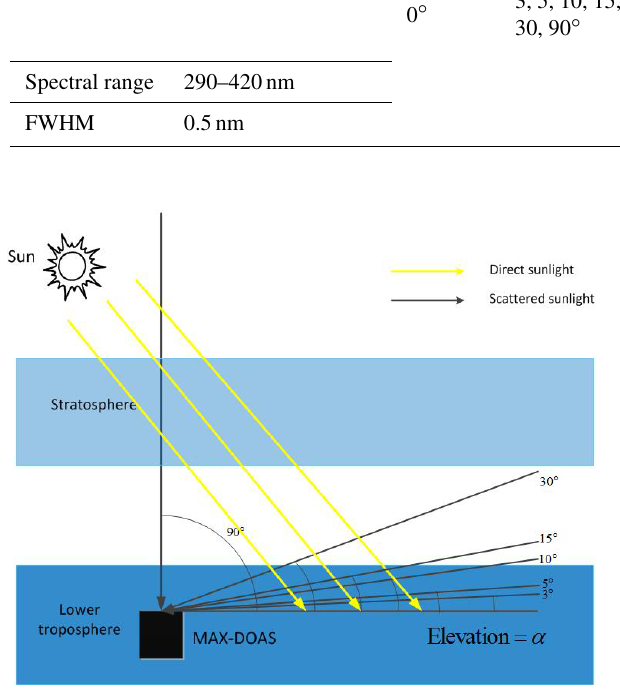
Figure 3. Observation geometry of